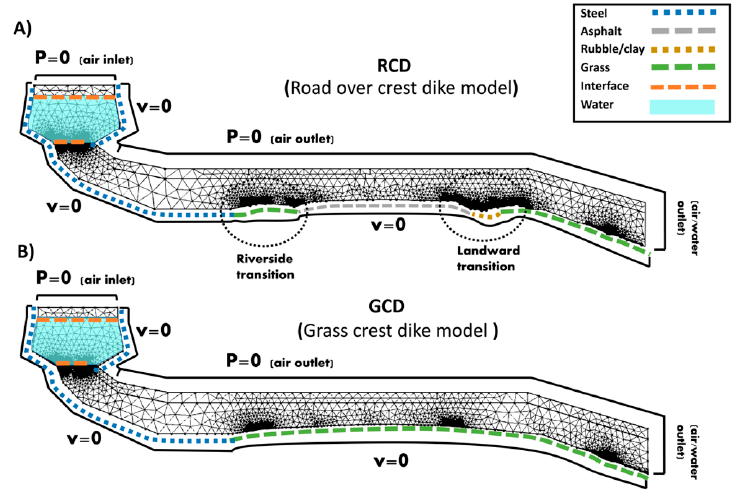
Figure 4. CFD models boundary conditions of ( A ) Road over crest dike model and ( B ) Grass over crest dike model (schematic meshing not in actual size on both models).